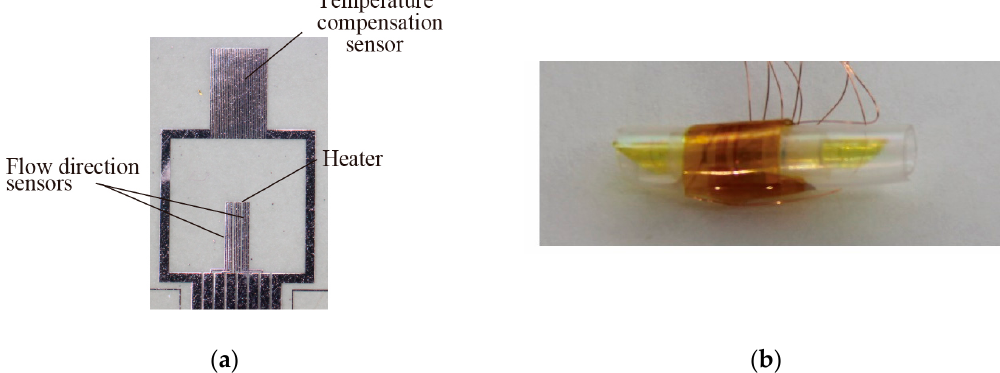
Figure 4. Fabricated sensor film and tube flow sensor: ( a ) Sensor elements on polyimide film; ( b ) Tube flow